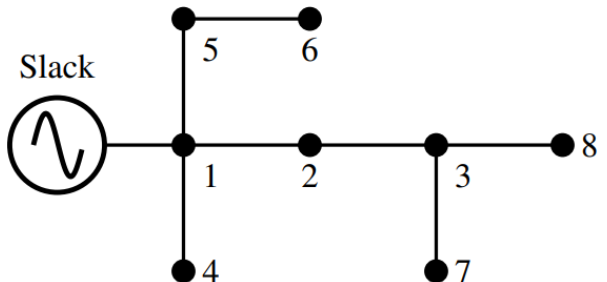
Figure 2. Single-line diagram of the 8-bus test